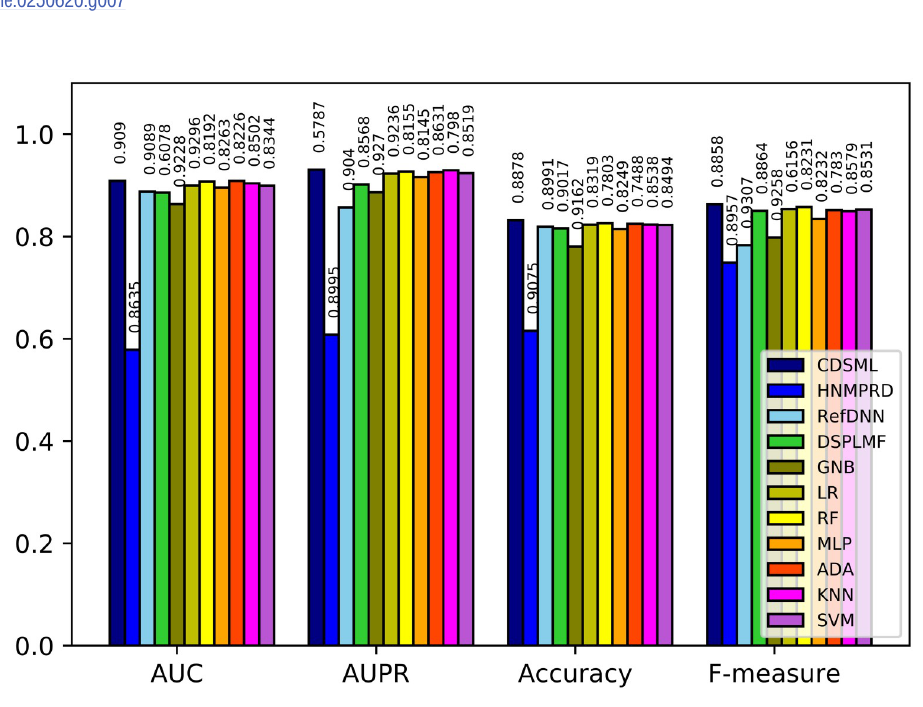
Fig 8. The performance of methods in on NSCLC tissue.